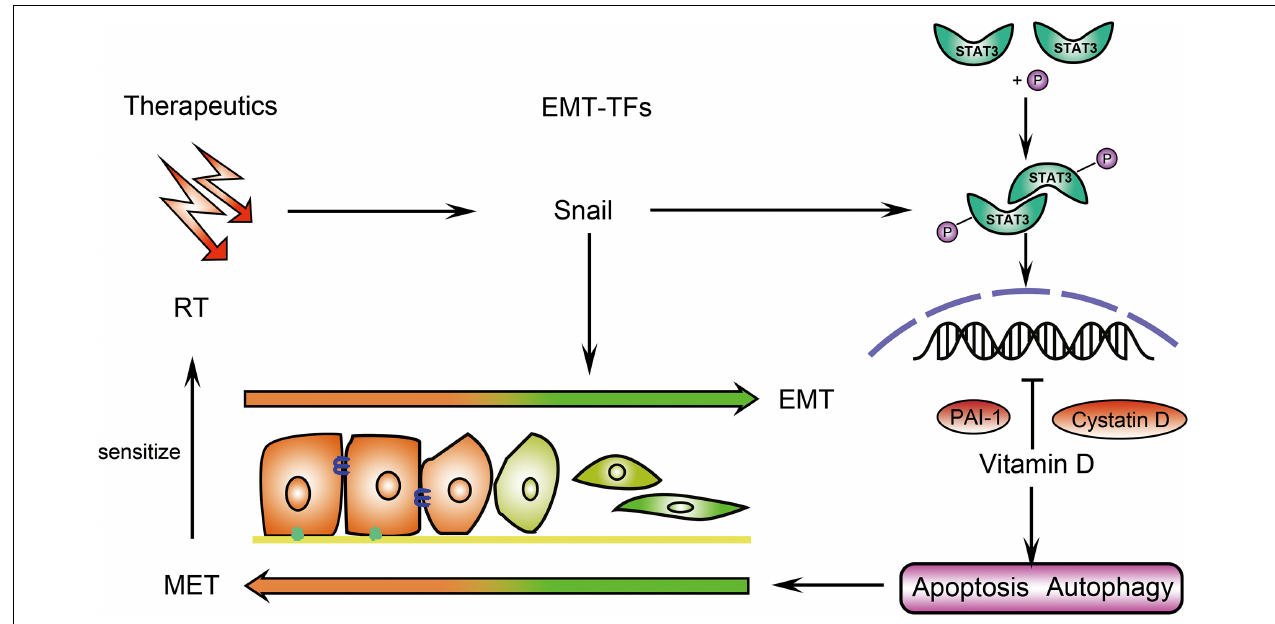
FIGURE 7 | Schematic illustration of how vitamin D promotes the radiation sensitivity of CRC. In CRC cells, vitamin D promoted cystatin D and PAI-1 to inhibit p-Stat3 expression, which was induced by EMT-inducing transcriptions factors (EMT-TFs) Snail and thus contributing to EMT. The induction of apoptosis and autophagy by vitamin D ultimately increased the sensitivity of the tumor to radiotherapy